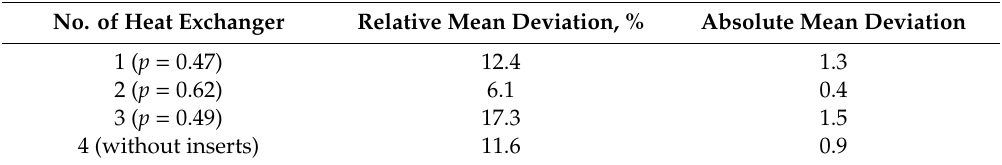
Table 1. Average relative and absolute deviations between freon temperature at the HE outlet obtained from theoretical calculations and their empirical values.